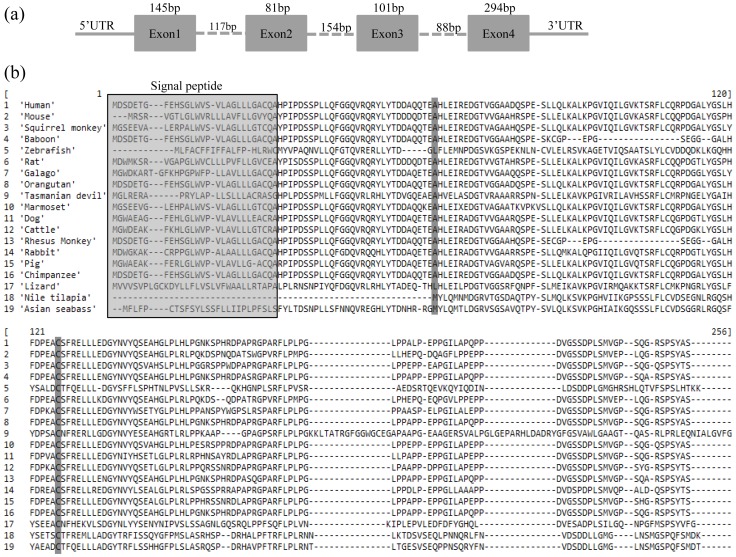
Genomic structure (a) and deduced amino acid sequence alignment (b) of the Fgf21 gene in Asian seabass.Marked columns denoted the corresponding position of conserved cysteine residues across FGF family. Sequences used for alignment were shown in supporting information Table S1.